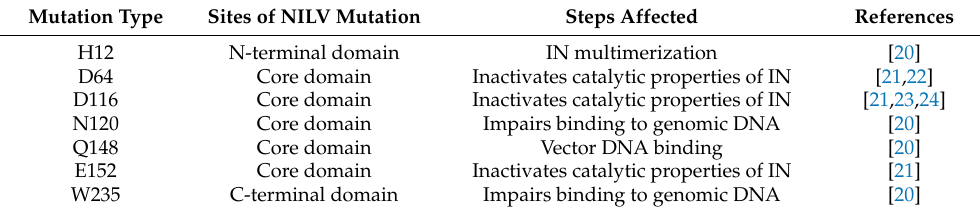
Table 3. Summary of point mutations and affected functions in IN that have been used to develop NILVs.